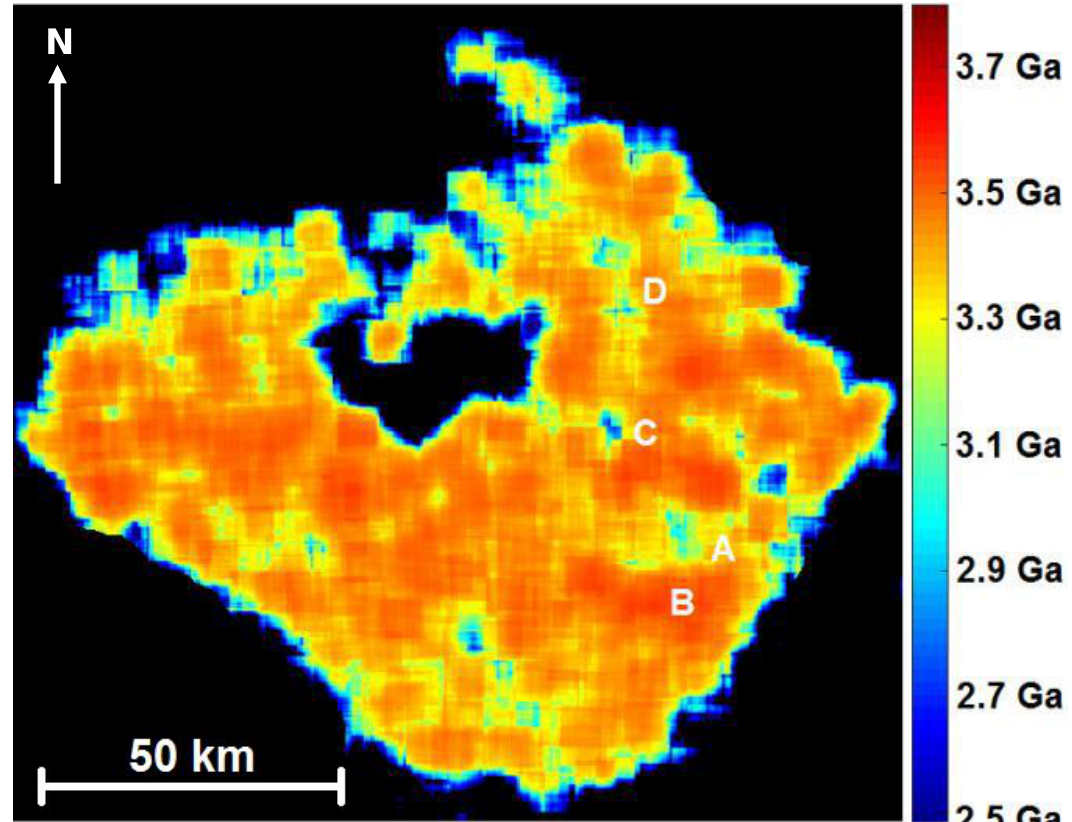
Figure 5. AMA map of the floor of the crater Tsiolkovsky. The mare-like floor region has been extracted manually. Black: no